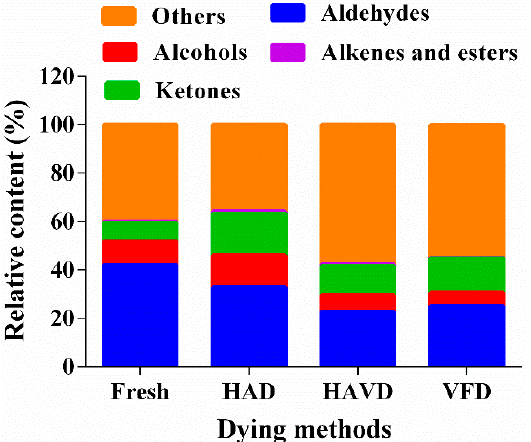
Figure 4. The relative content of volatile flavor compounds of L. decastes with different drying method treatments. HAD: hot-air-drying sample; HAVD: hot-air-combined-with-vacuum-drying sample; VFD: vacuum-freeze-drying sample.